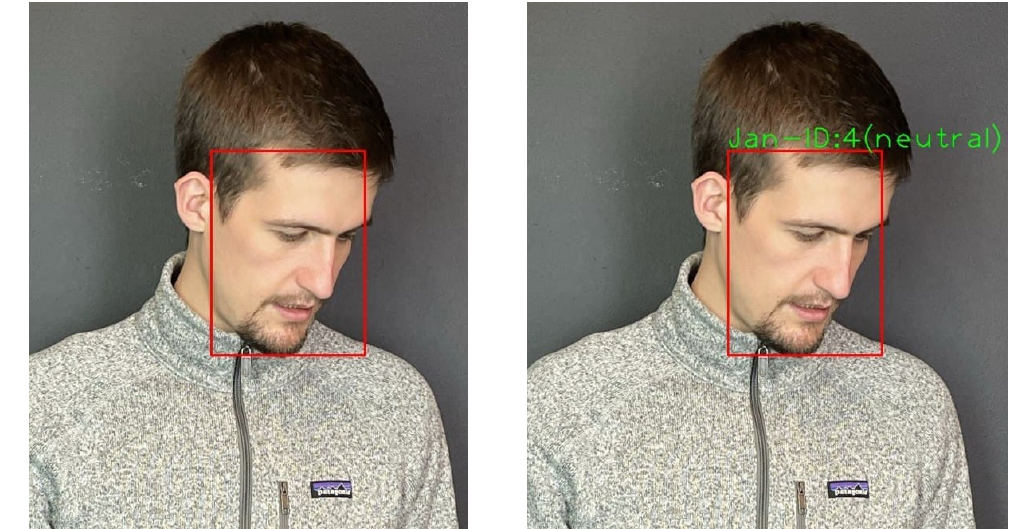
Figure 12. Face detection, face recognition, and facial expression